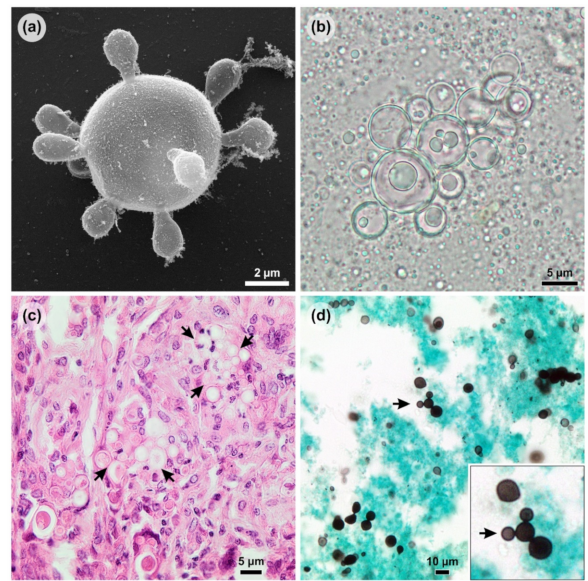
Figure 4. Morphological aspects of Paracoccidioides yeast. ( a ) Paracoccidioides lutzii showing multiple buds with a “steering wheel” shape in vitro (scanning electron microscopy); ( b ) The positive direct mycological examination of pus showing large yeasts (5–15 µ m) that have a thick, birefringent cell wall with single or multiple buds; ( c ) Paracoccidioides spp. in tissue (arrows) stained by hematoxylin and eosin (HE); ( d ) Paracoccidioides spp. in tissue stained by Grocott’s methenamine silver (GMS) showing a “Mickey Mouse” shape